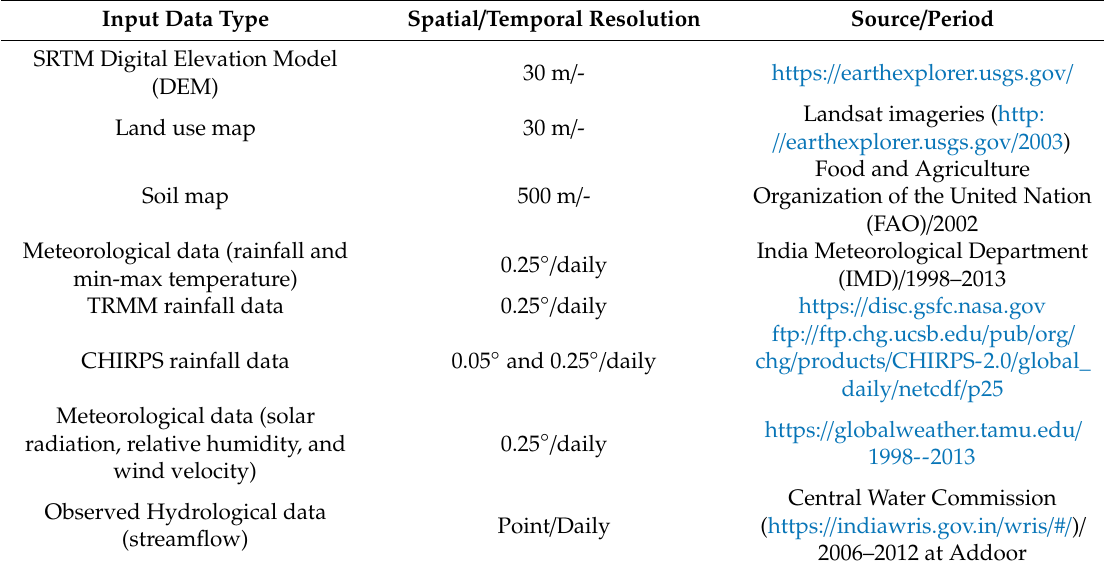
Table 1. Data source and